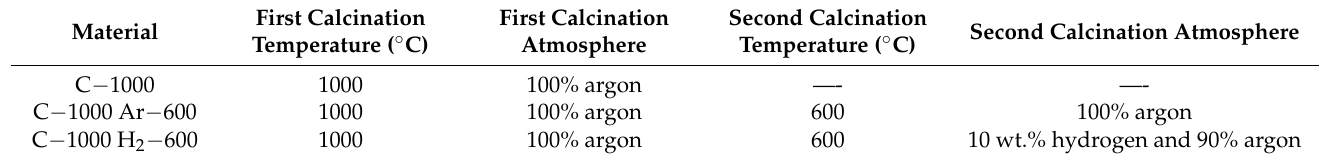
Table 1. Sample names and their